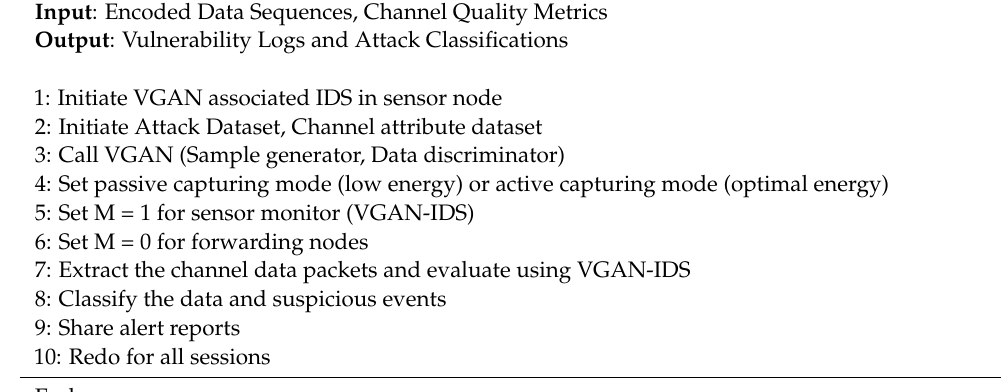
Figure 4. System design of proposed DMCAP phases . 4. Experiments and Results